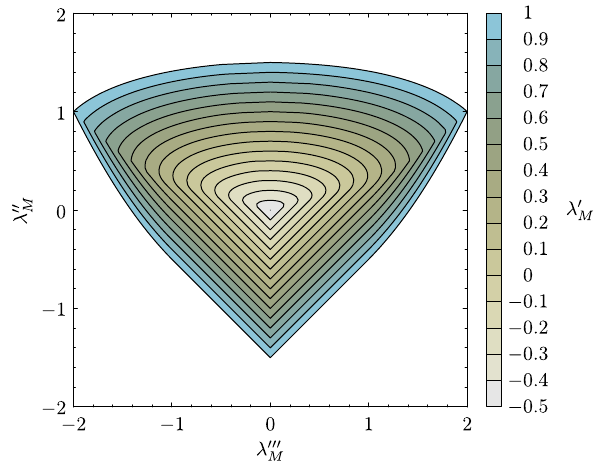
Fig. 1 Allowed parameter space for the matrix self-couplings from vacuum stability for λ M = 0 . 5 and − 1 (cid:2) λ (cid:3) ‘mountain’ is at λ (cid:3)(cid:3)(cid:3)